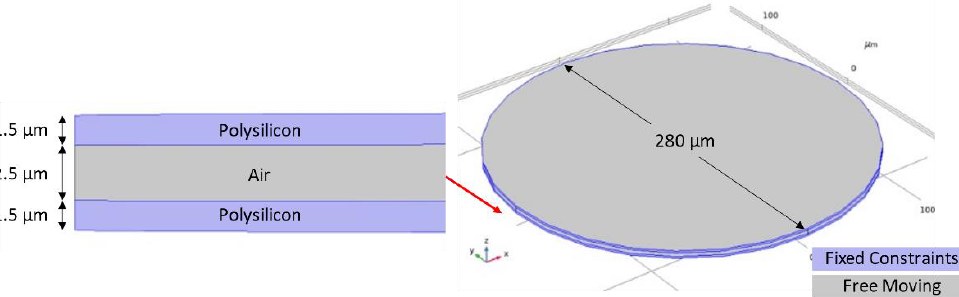
Figure 1. Clamped membrane structure used for validation and mesh refinement study.